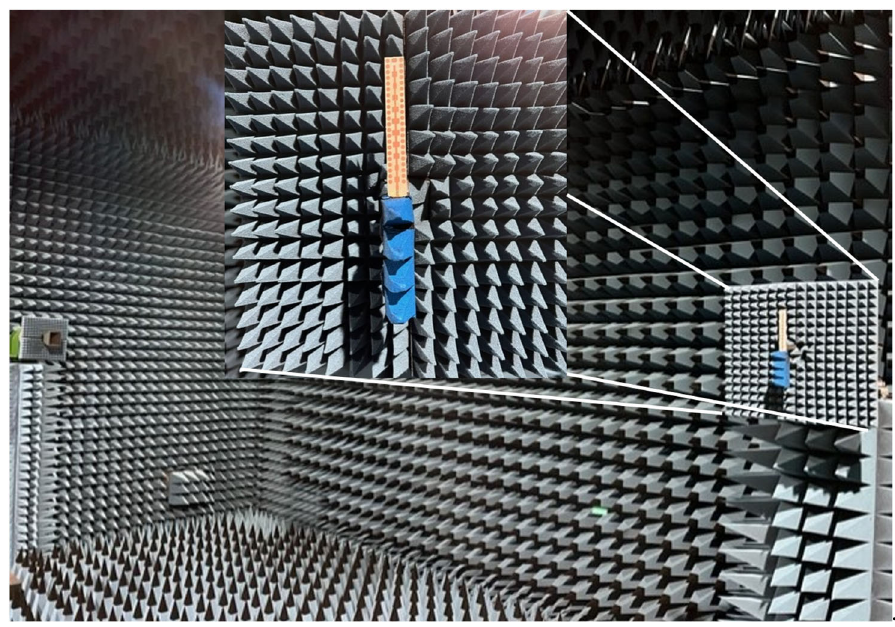
Figure 9. Measurement set-up in an anechoic chamber for radiation properties with zoomed detail of an antenna under test (AUT).